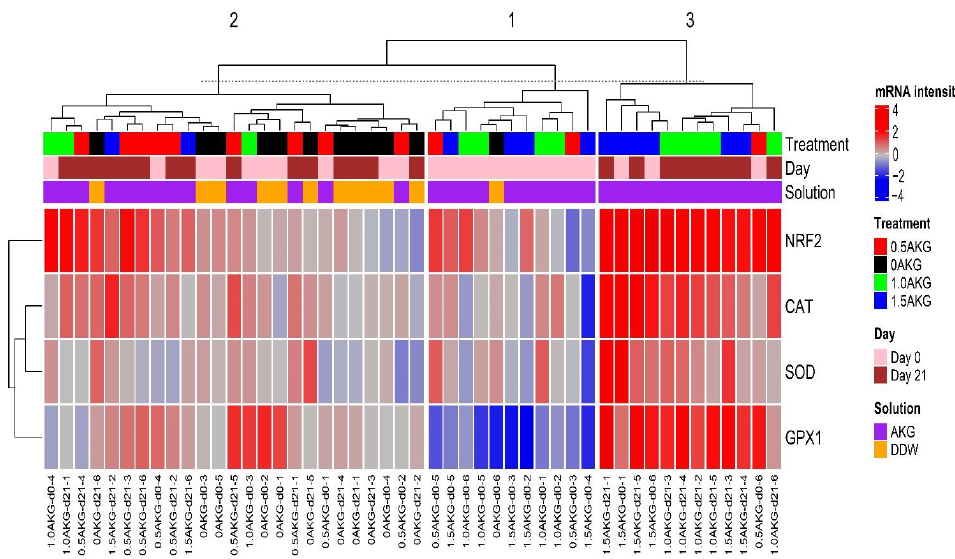
Figure 2. Heat map showing the hierarchical cluster of hepatic mRNA gene expression of antioxidant-related genes (NRF2, CAT, SOD, GPX1) at day 0 and day 21 old broilers. Each row represents a gene and each column represents an experimental unit belonging to a specific treatment. At 17.5 day of incubation, eggs were given an in ovo injection of 0%, 0.5%, 1.0%, and 1.5% AKG solution prepared in DDW, and the treatments are described as 0 AKG, 0.5 AKG, 1.0 AKG, and 1.5 AKG, respectively. The chicks were raised in a thermoneutral environment as per standard guidelines of rearing for the entire rearing period. RT-qPCR was used for gene expression analysis. GAPDH and β -actin were used as reference genes, the fold change (FC) of the genes was calcula ted as 2−ΔΔCt. The relative gene expression values were obtained as log2(FC). The tree was constructed using the package “ComplexHeatmap” of the R software version 4.0.3 (R Core Team, 2020). Abbreviations: NRF2, nuclear factor erythroid 2-related factor; CAT, catalase; SOD, superoxide dismutase; GPX1, glutathione peroxidase 1.